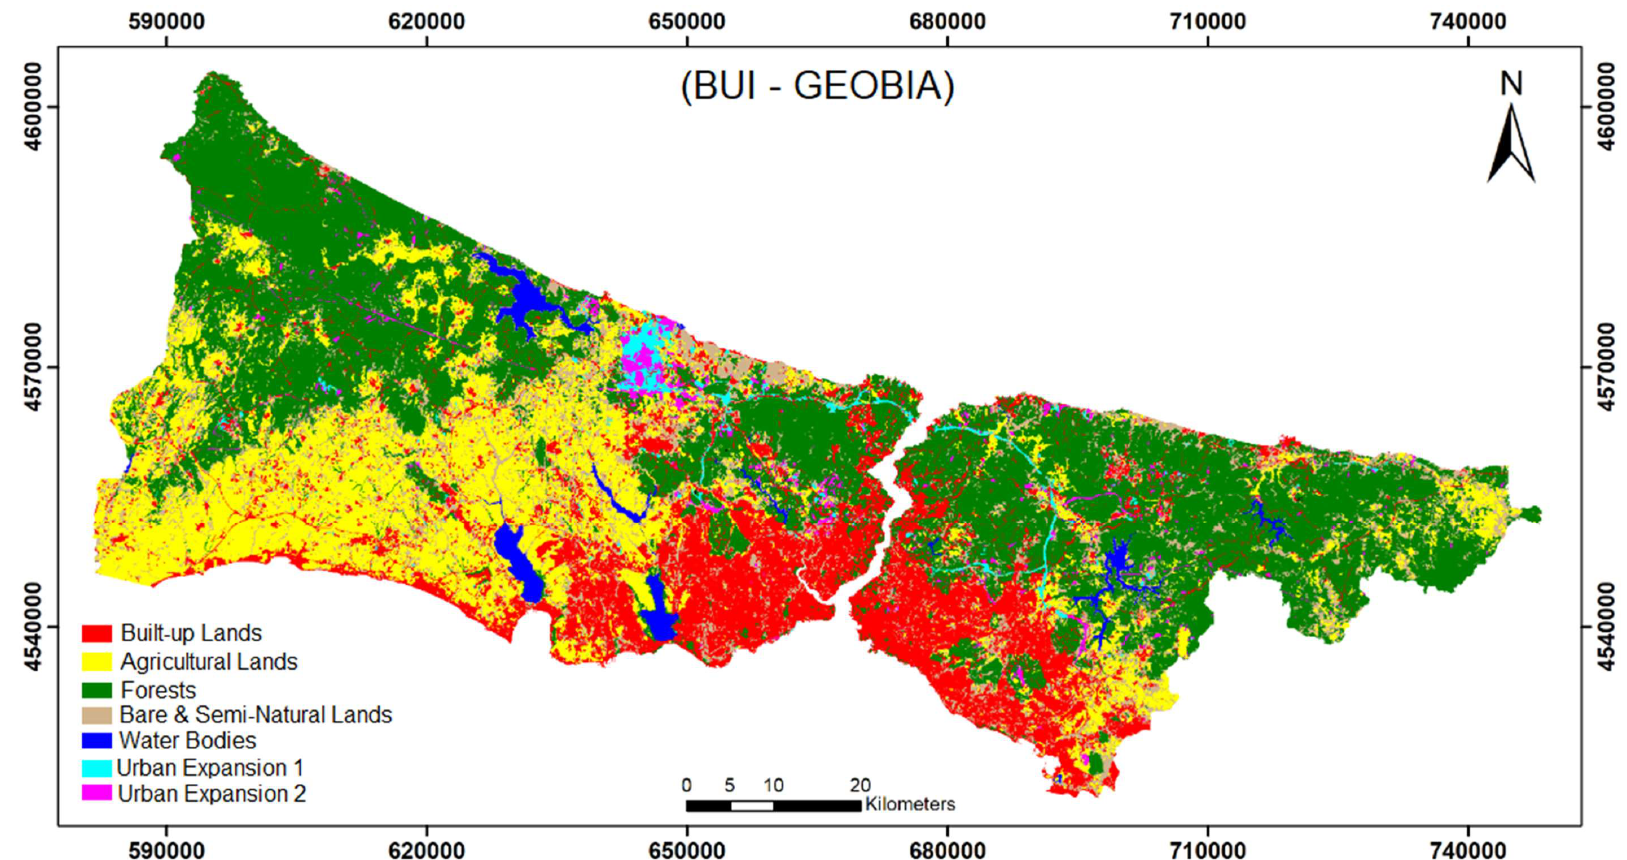
Figure A3. GEOBIA classification results of the BUI dataset.